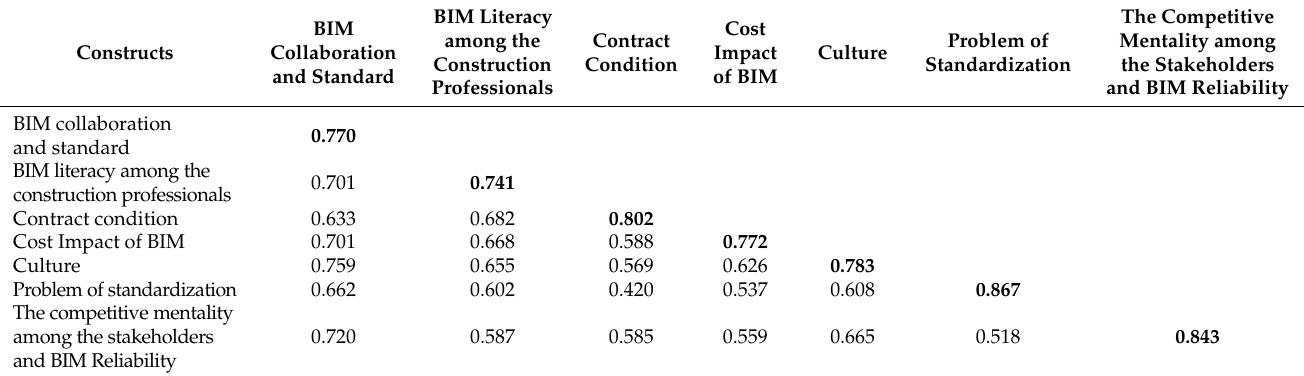
Table 7. Discriminant validity analysis (Fornell–Larcker).